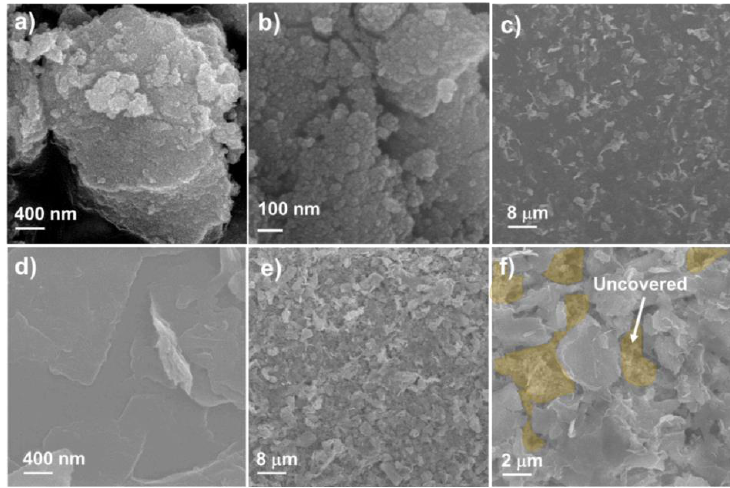
Figure 2. Scanning electron microscope (SEM) images of ( a , b ) SnO 2 nanoparticle (NP) powder, ( c , d ) single-layer MoS 2 NS thin film on Cu electrode, and ( e , f ) M1SnO 2 anode.